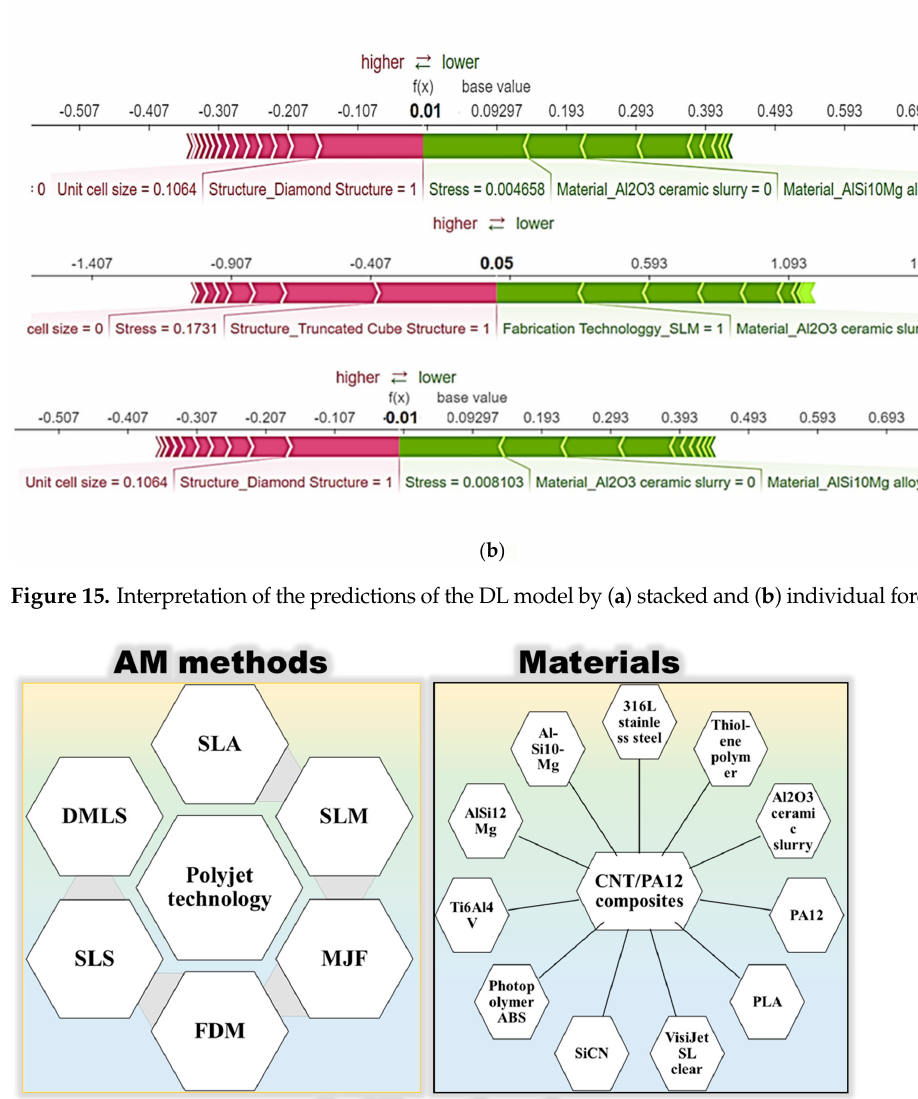
Figure 16. Applicability of the developed method.